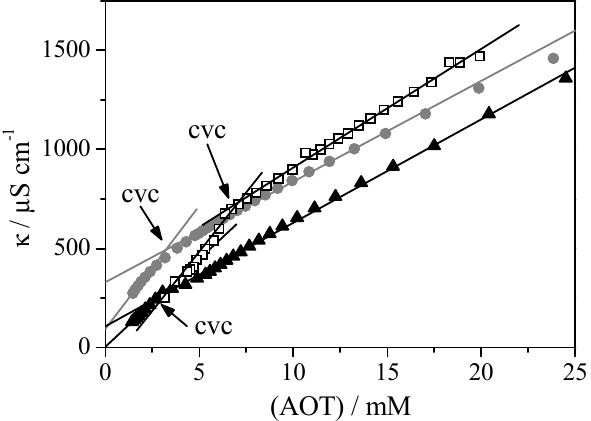
Figure 1. Electrical conductivity values of surfactant solutions : (triangles) sodium bis(2-ethyl-hexyl) sulfosuccinate (Aerosol OT or AOT) dissolved in 0.0001% of poly(allylamine) (PA), (circles) AOT dissolved in 0.02% PA and (squares) AOT dissolved in 0.094% poly(maleic anhydride-alt-1-octadecen)